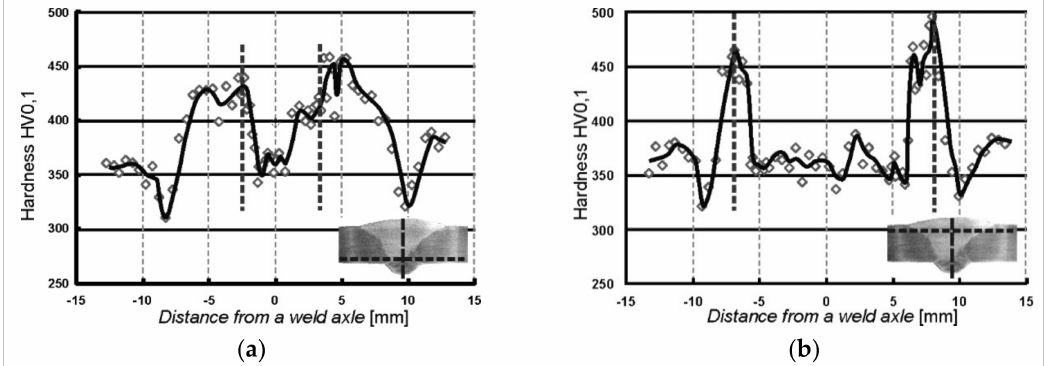
Figure 7. Distribution of micro-hardness measured in the WJ-V joint on: ( a ) root side; ( b ) face